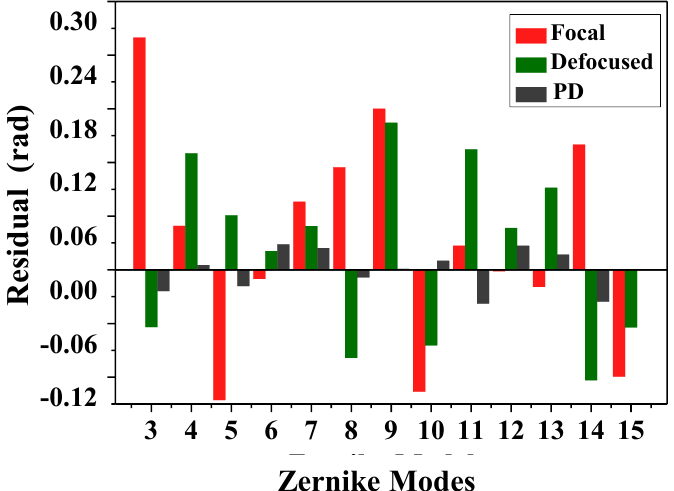
Figure 12. The residual wavefronts of the three models of PD-CNN, when the input the images of the sample shown in Figure 8. The unit of residual wavefront is